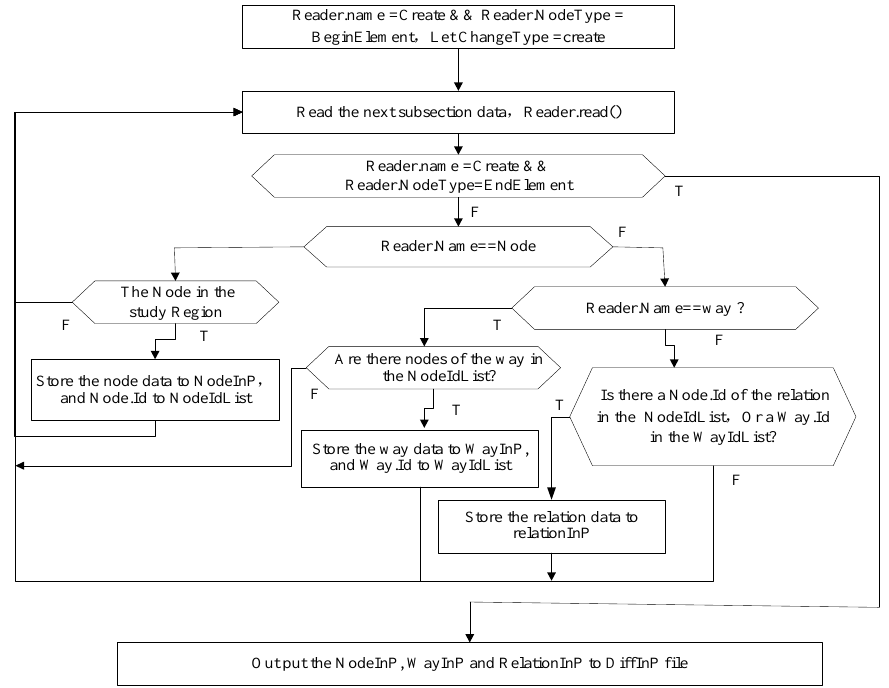
Figure 3 Selecting the objects in the researching region using “create” section as an